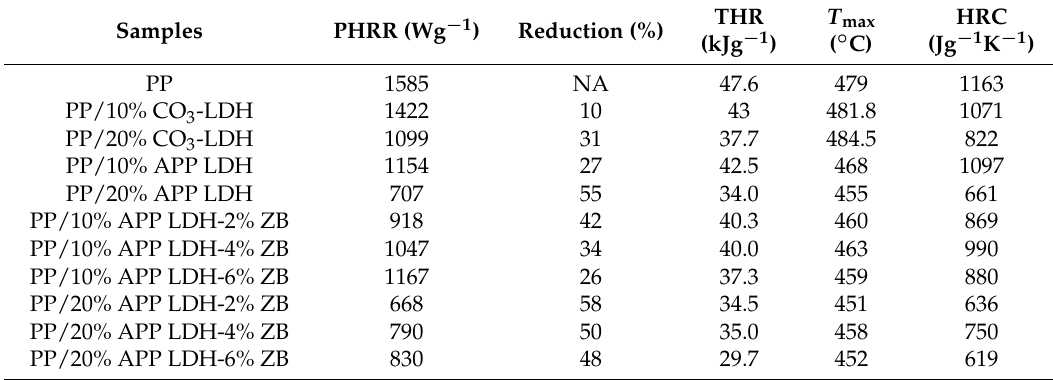
Table 2. Summary of microscale combustion calorimeter (MCC) results for PP, PP/APP-LDH, and PP/APP-LDH/ZB nanocomposites a